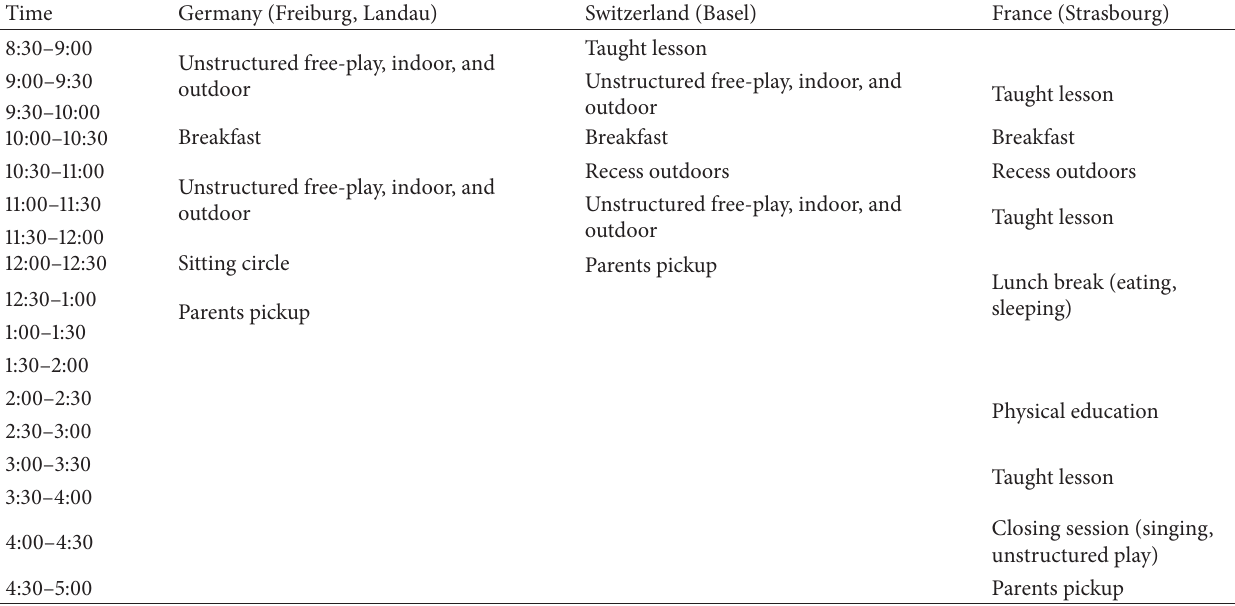
Table 1: Timetables of preschools in the different locations.